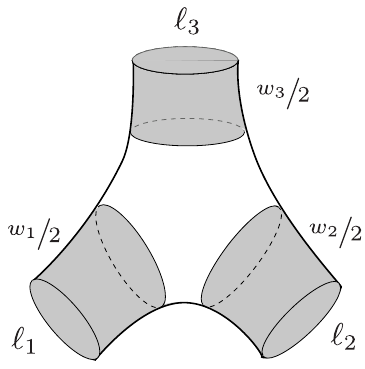
Figure 3 . Hyperbolic pants with the half-collars associated with the boundary geodesics. When ‘ 1 = ‘ 2 = ‘ 3 = L < L ∗ the half collars shown are all of length greater than L/ 2